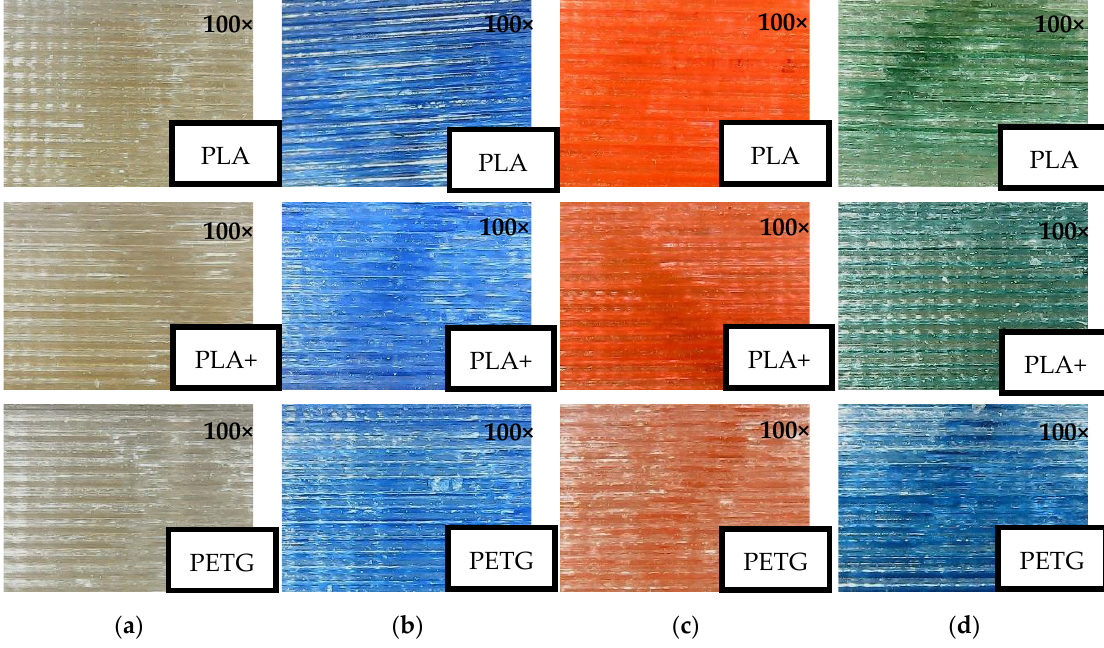
Figure 19. Surface analysis: ( a ) uncoloured filament; ( b ) blue pigment; ( c ) red pigment; ( d ) green pigment.